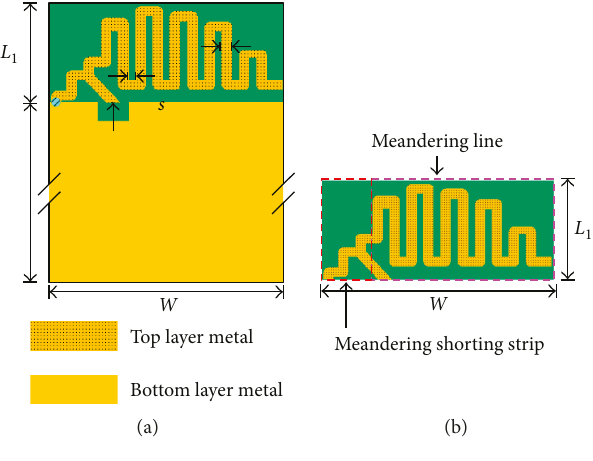
Figure 3: (a) Proposed antenna. (b) Antenna with meandering line and meandering shorting strip.